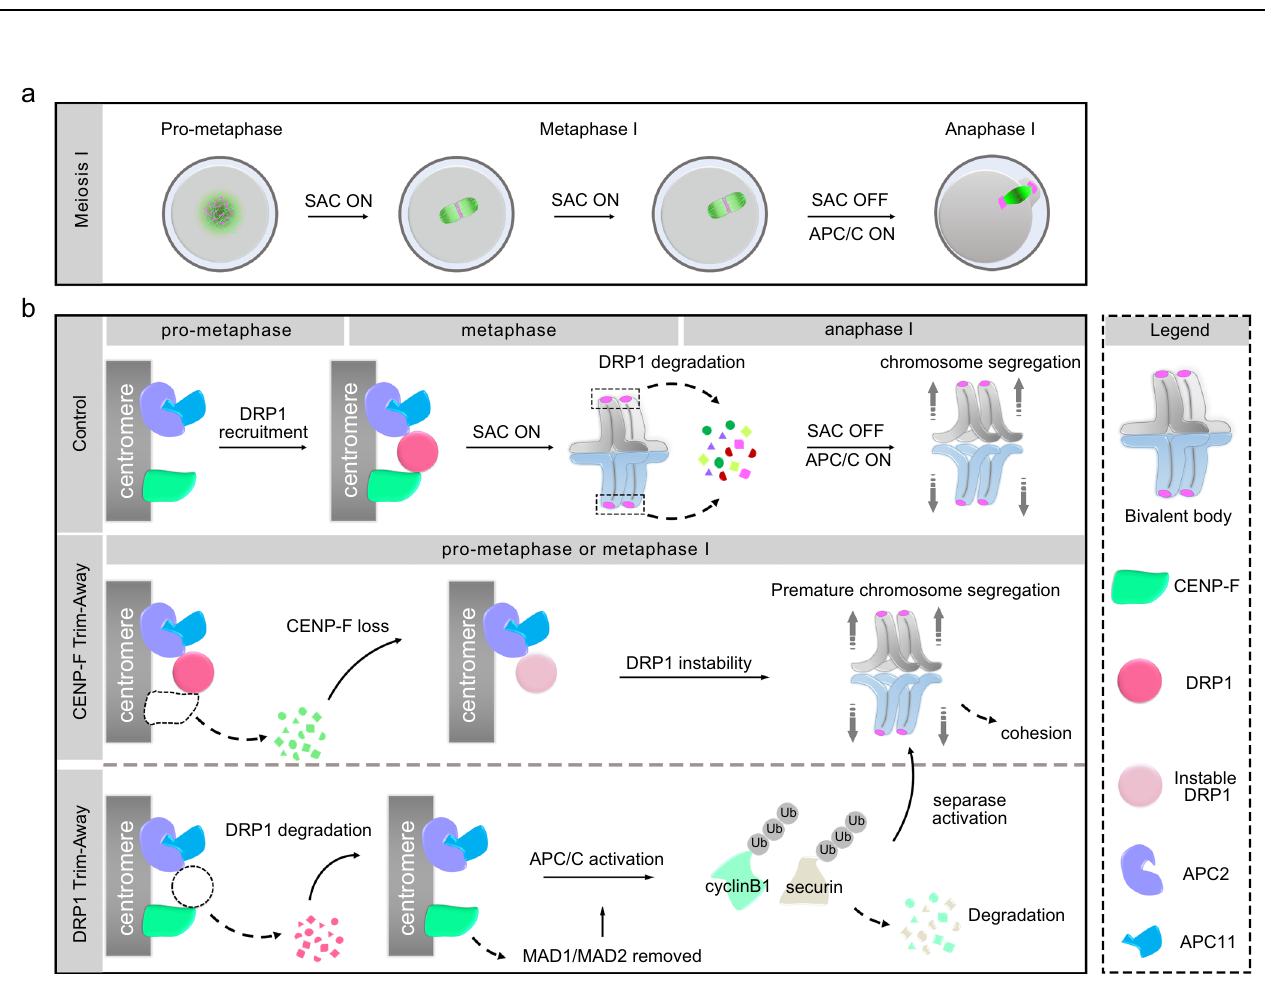
Fig.7|SchemeshowingDRP1regulationofmetaphase-to-anaphasetransitionduringoocytemeiosisI.a SACandAPC/Cregulatemouseoocytemeioticprogression. b Centromeric DRP1 is a CENP-F-dependent key regulator in maintaining SAC activity by targeting APC2 to control anaphase